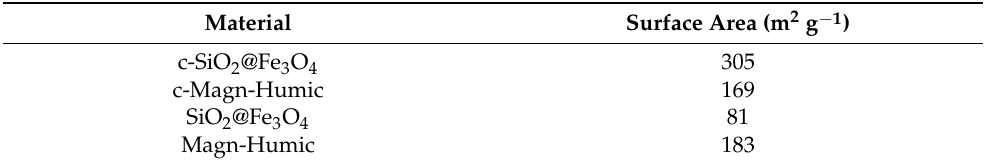
Table 1. Surface area values determined by Brunauer, Emmett, and Teller (BET) method (relative standard deviation (RSD) < 5%, n = 3).